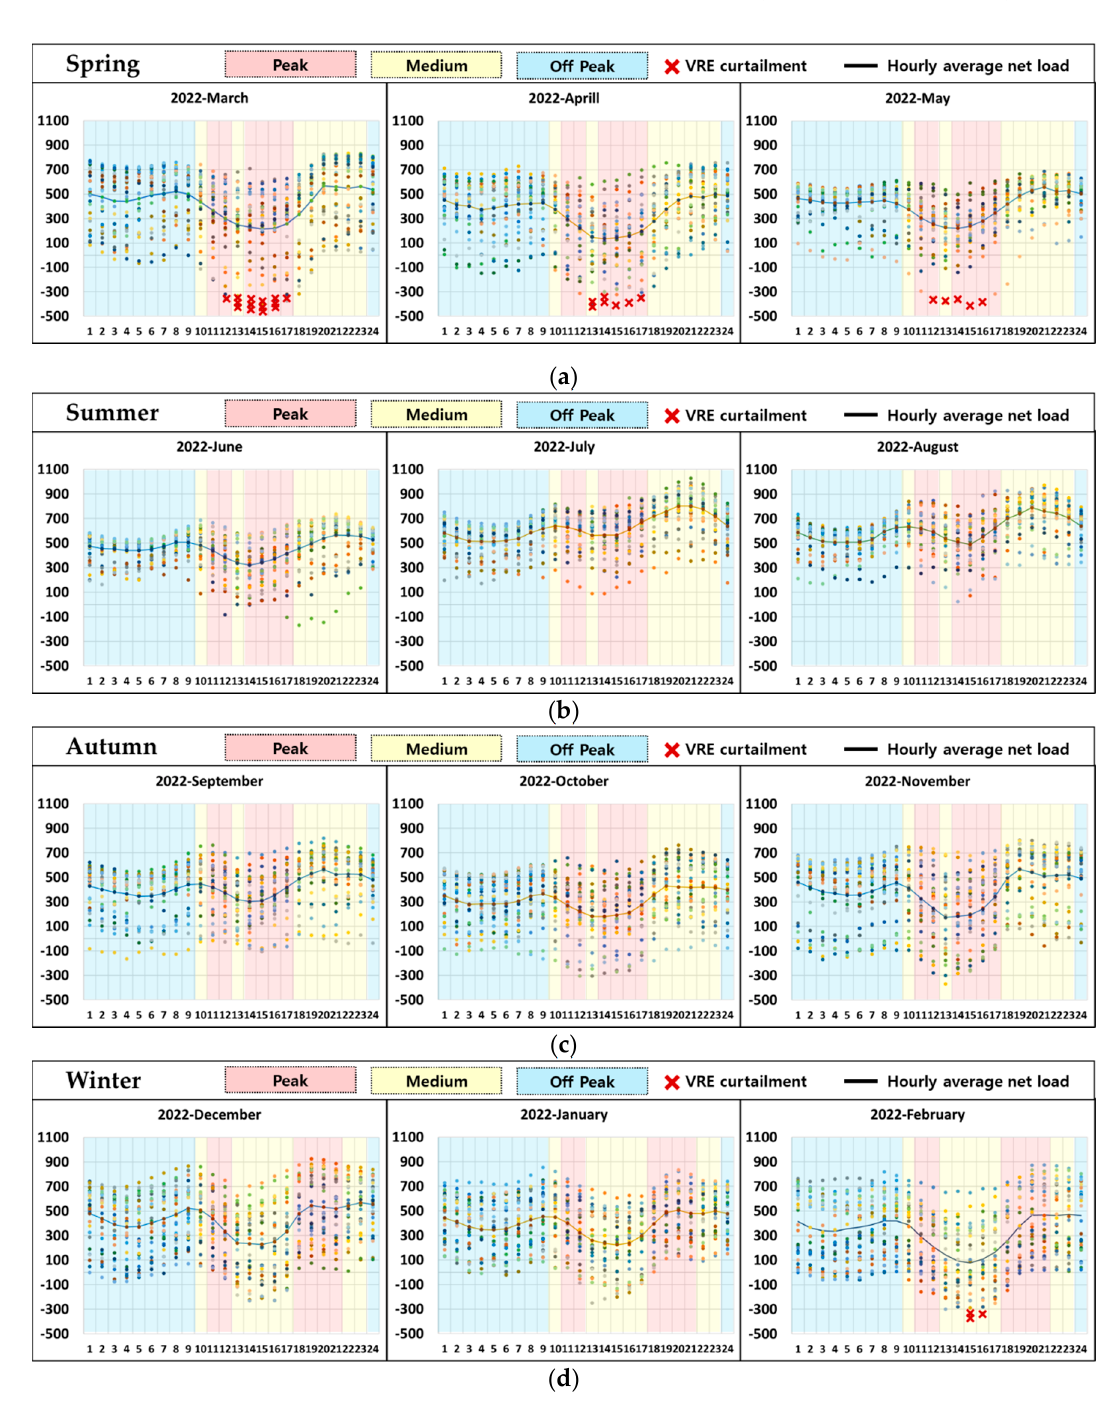
Figure 7. Estimated seasonal monthly net load curve in Jeju 2022: ( a ) spring; ( b ) summer; ( c ) autumn; ( d ) winter.